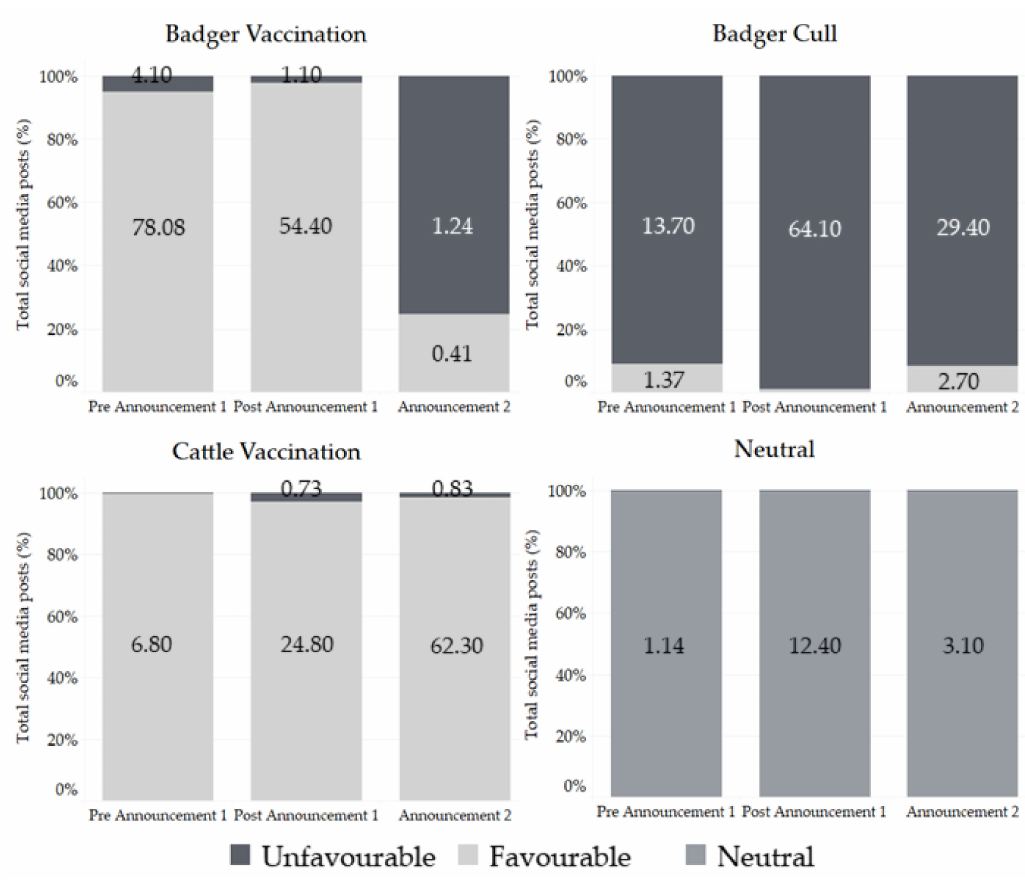
Figure 3. Bar graphs demonstrating the percentages of the total number of relevant digital and social media posts that were categorized as either unfavorable, favorable or neutral in reference to the topics of badger vaccination, badger culling, cattle vaccination, or neutral for the periods: pre-Announcement-1; post-Announcement-1; and